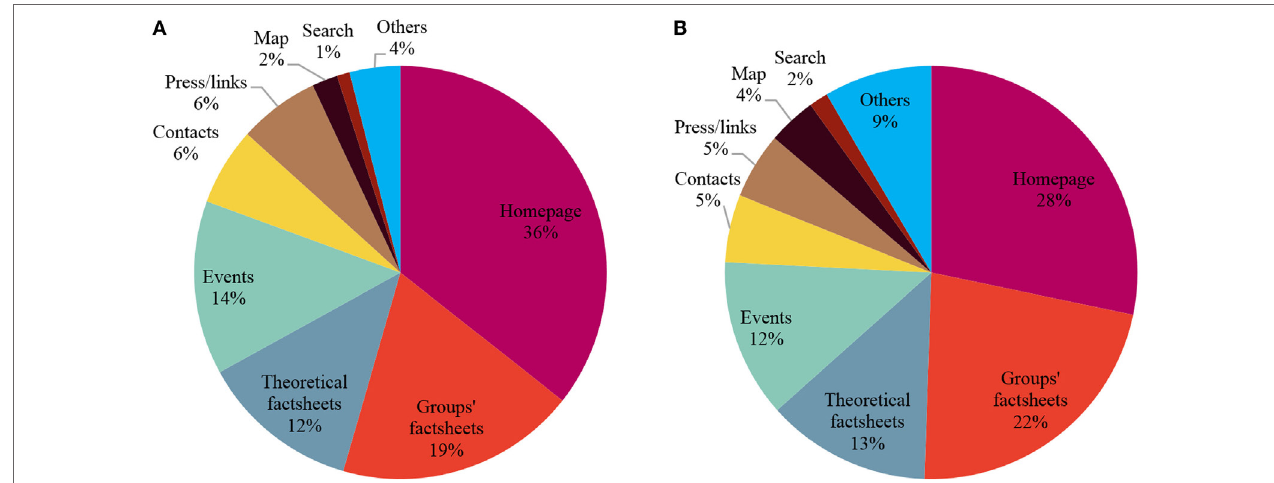
FigUre 4 | Pie charts of the percentages of the page views per section on www.sport-sante.lu during the control [(a), total number of viewed pages: 1,990] and the testing [(B), total number of viewed pages: 12,087] periods